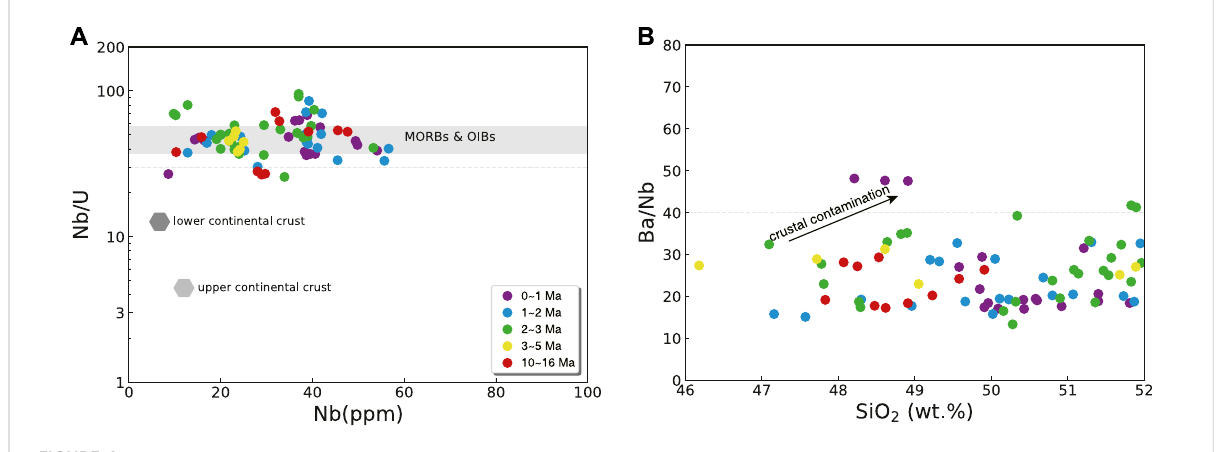
FIGURE 4 (A) Nb/U vs. Nb. (B) Ba/Nb vs. SiO 2 . In (A) , the gray area is Nb/U of mid-ocean ridge basalts (MORBs) and ocean island basalts (OIBs) (Hofmann et al., 1986). Data for the upper continental crust and lower continental crust is from Rudnick and Gao (2014). The arrow in (B) indicates a crustal contamination